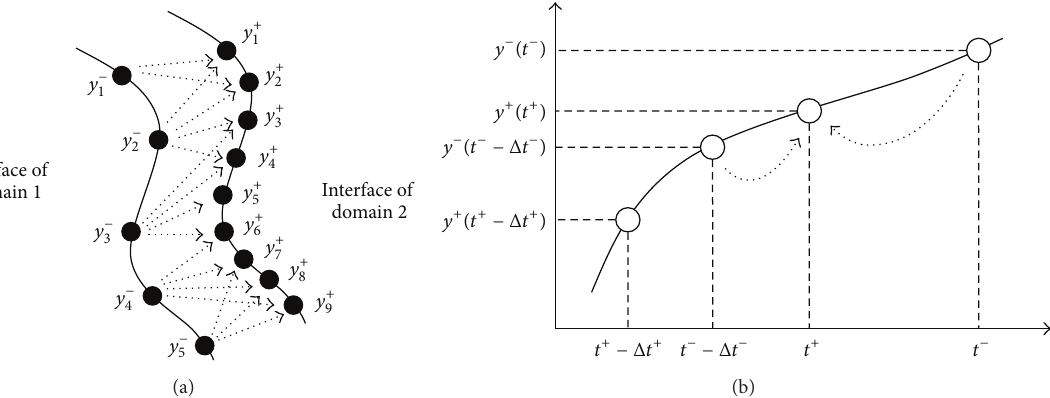
Figure 2: (a) Sketch for a spatial interpolation of nodal values on the interface: 𝑦 + 1 = 𝐼(𝑦 − 1 ,𝑦 − 2 ) , 𝑦 + 2 = 𝐼(𝑦 − 1 , 𝑦 − 2 ) , 𝑦 + 3 = 𝐼(𝑦 − 2 , 𝑦 − 3 ) , and so forth; (b) sketch for a temporal interpolation of time-step values on the interface: 𝑦 + (𝑡 + ) = 𝐼(𝑦 − (𝑡 − ),𝑦 − (𝑡 − − Δ𝑡 − )) , and so forth, where 𝐼 stands for a linear interpolation